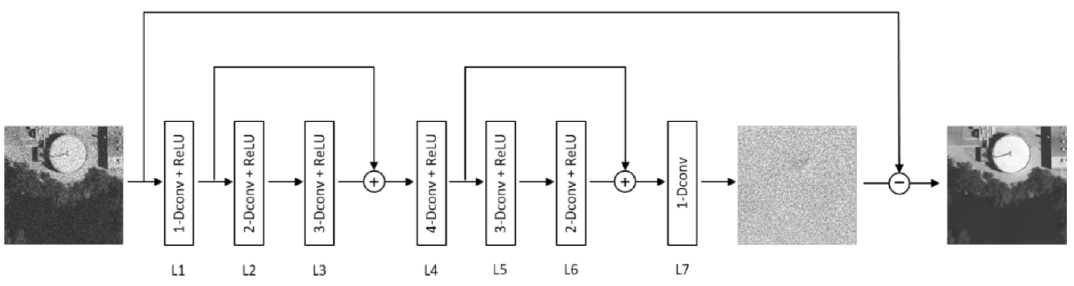
Figure 2. SAR-DRN